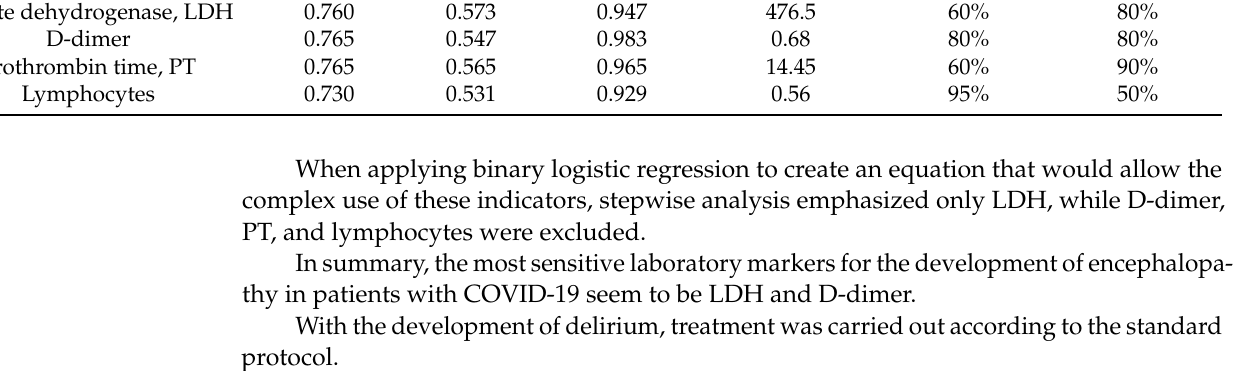
Table 6. Characteristics of the area under the curve and the cutoff values for the studied markers.